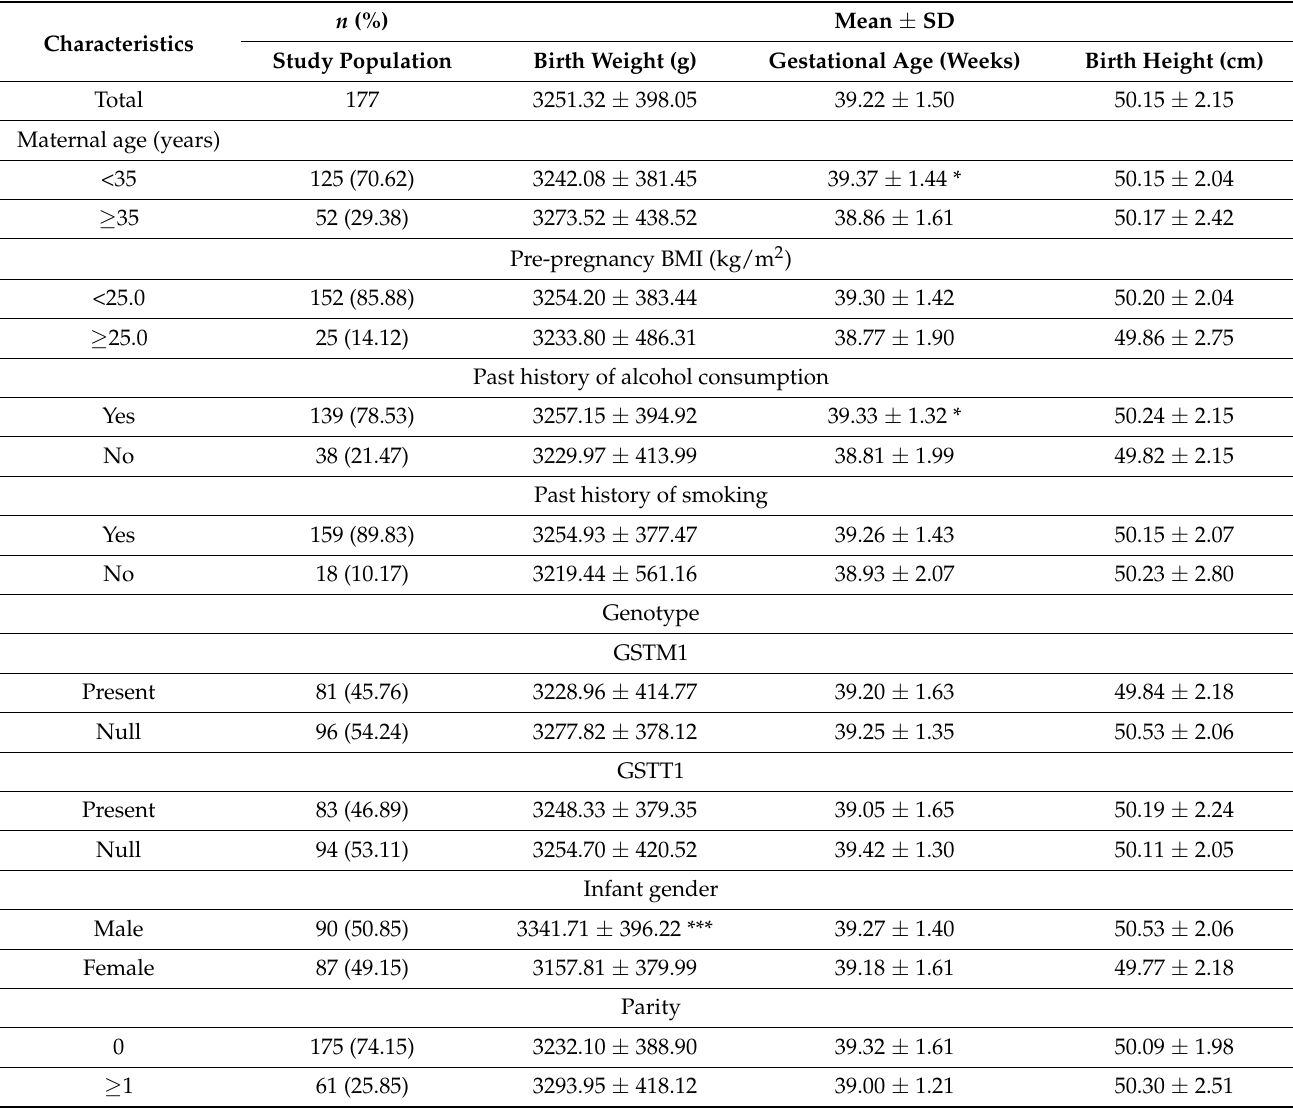
Table 1. General characteristics of study subjects a